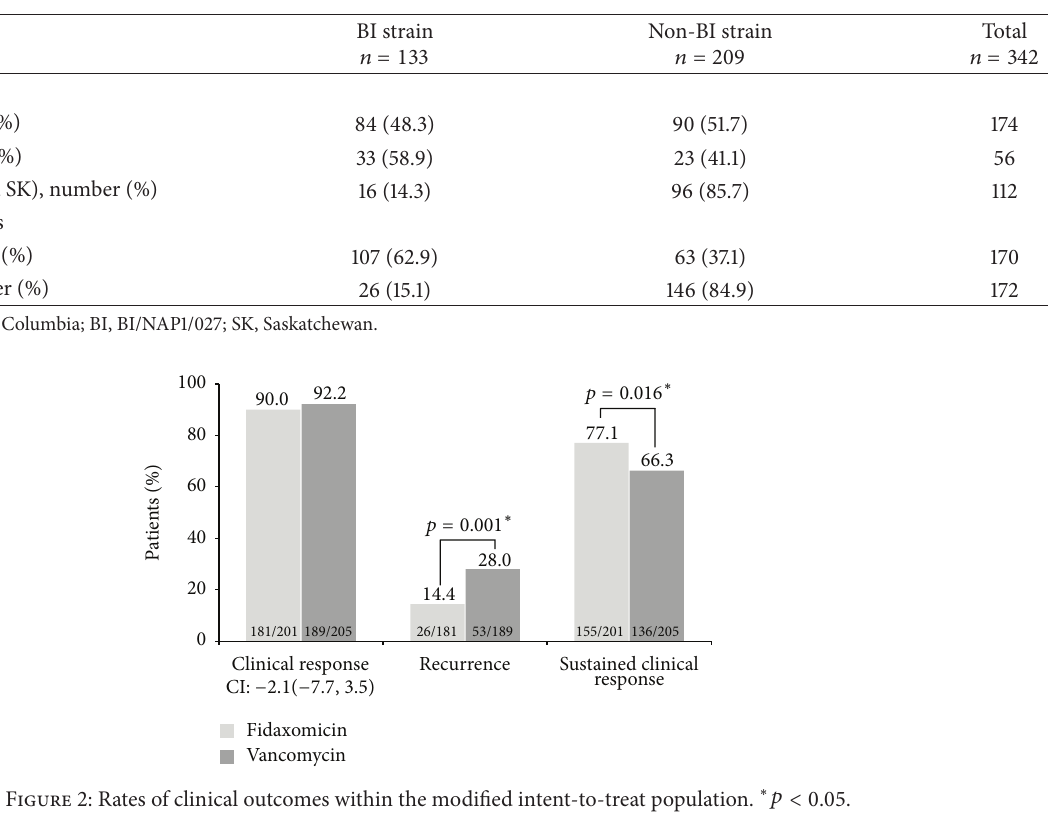
Table 2: Distribution of patients with BI and non-BI strains by region and hospitalization status at time of randomization.